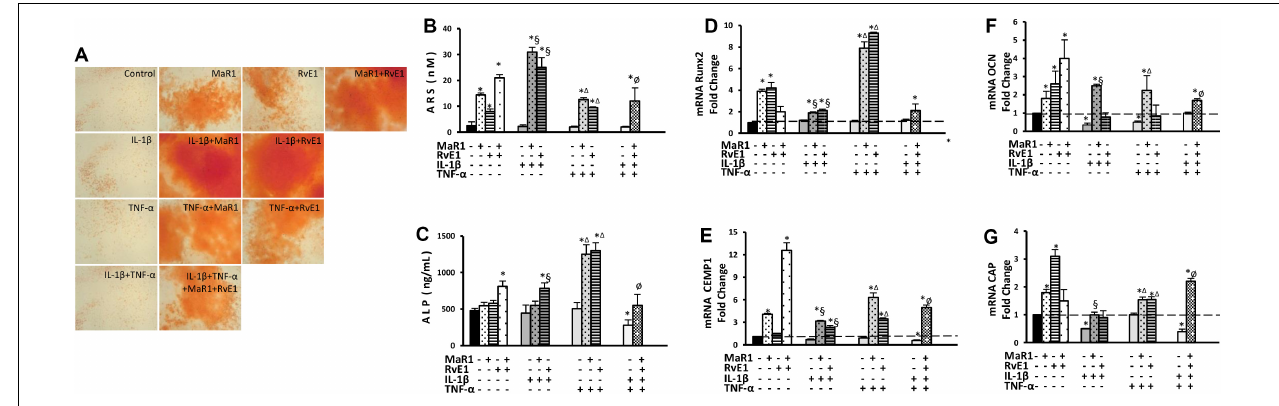
FIGURE 4 | Analysis of hPDLSCs cementogenic-osteogenic differentiation after 7-day treatment in the osteogenic medium under different experimental conditions. (A) Representative figures for each condition showing ARS calcified deposits. (B) quantification (in nM) of extracted ARS calcified deposits. (C) the concentration of alkaline phosphatase (ALP; in ng/mL) measured at supernatants. (D–G) relative gene expression. (mRNA) of cementogenic-osteogenic markers (Runx2, Osteocalcin/OCN, CEMP1, and CAP) evaluated by qPCR using GAPDH as endogenous control and the (cid:49)(cid:49) CT method. (*) p < 0.05 vs control (non-stimulated); (§) p < 0.05 vs IL-1 β treated group; ( (cid:49) ) p < 0.05 vs TNF- α treated group; and ( ø ) p < 0.05 vs IL-1 β +TNF- α treated